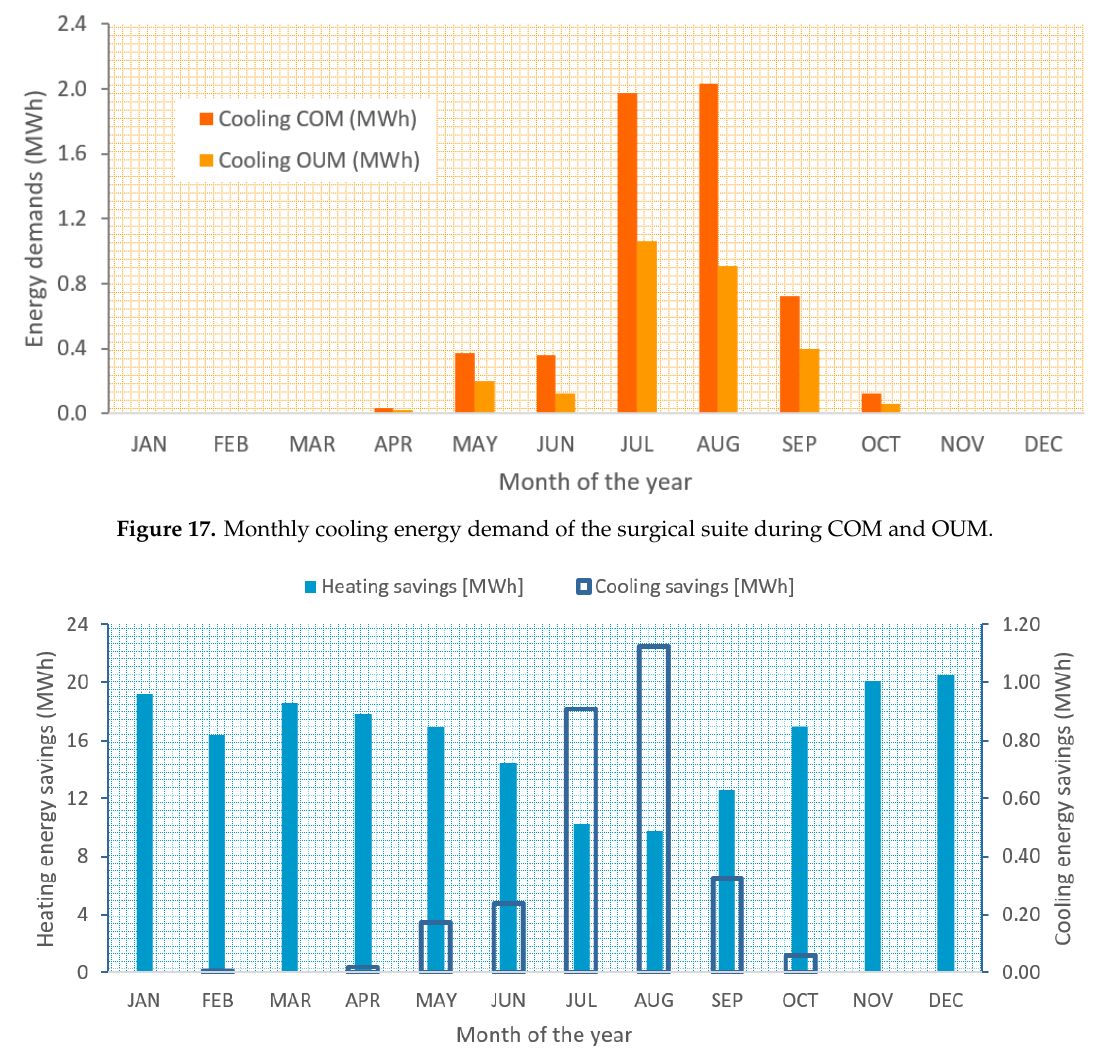
Figure 18. Monthly heating and cooling energy savings of the surgical suite using OUM.